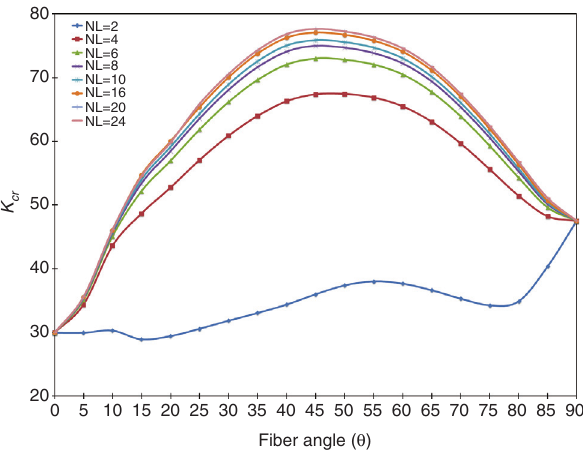
Figure 6 Critical buckling load parameter for simply supported antisymmetric cylindrical skew panel (Ø = 15 ° , α = 45 ° ).